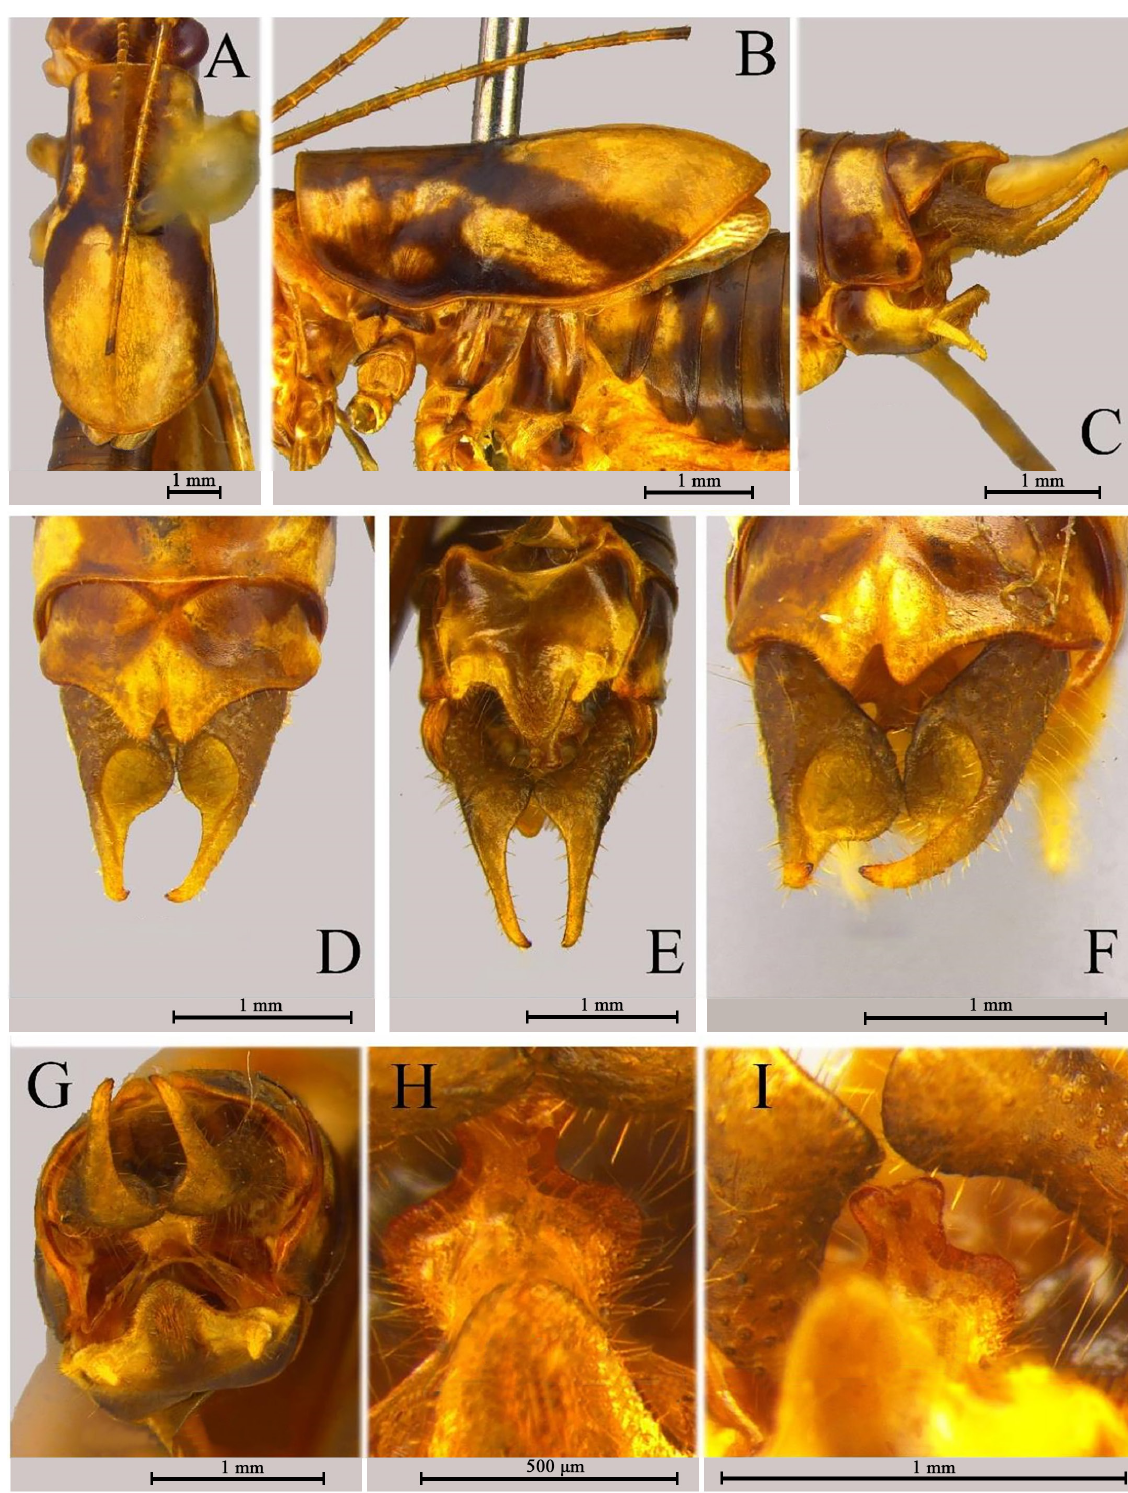
Fig. 3. Acosmetides platycerca gen. et sp. nov., holotype, ♂ (HBU). – A–B . Pronotum A . Dorsal view. B . Lateral view. – C–G . Apex of abdomen. C . Lateral view. D . Dorsal view. E . Ventral view. F . Dorso- apical view. G . Apical view. – H–I . Genitalia in ventral view. H . Basal area. I . Apical